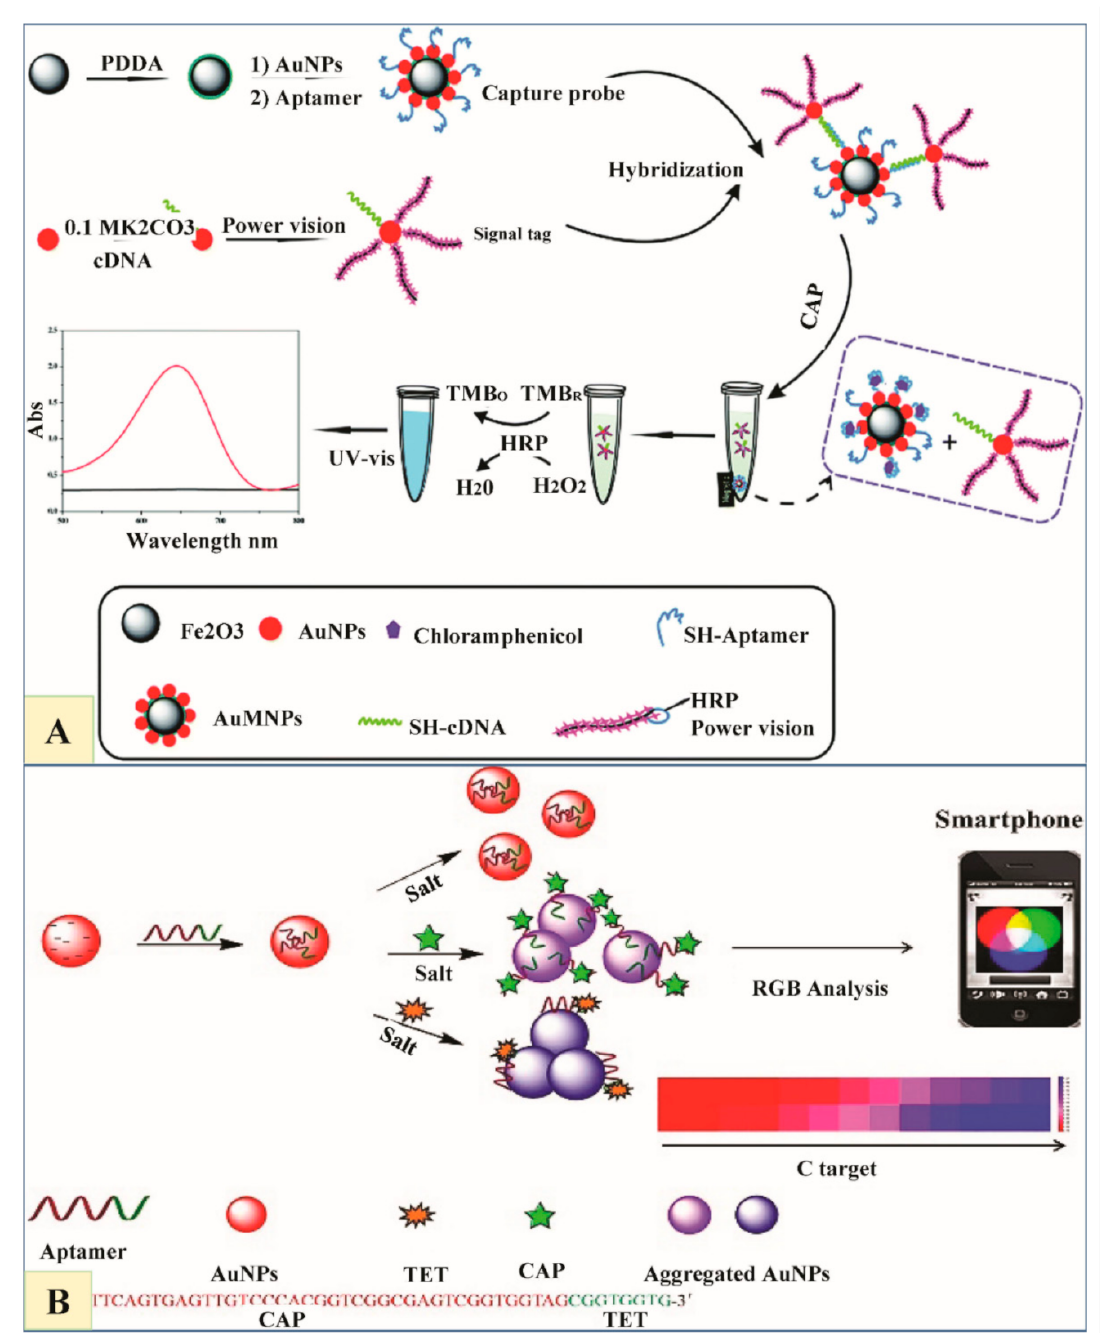
Figure 5. ( A ) Scheme showing the proposed working principle of CAP detection using cDNA–AuNPs–PV as a signal tag (Reproduced with permission from [79] © 2015 Royal Society of Chemistry). ( B ) Schematic diagram exhibiting TET/CAP detection in which the multi-Aptamer acts as a molecular switch adjusting the AuNPs aggregation. When a specific target removes the fragment of its particular Apt from the AuNPs surface, unbalanced AuNPs aggregation occurs at different scales under high-salt conditions, causing colloidal color changes, which can be detected by UV-spectrum and Smartphone analysis, respectively (Reproduced with permission from [81] © 2020